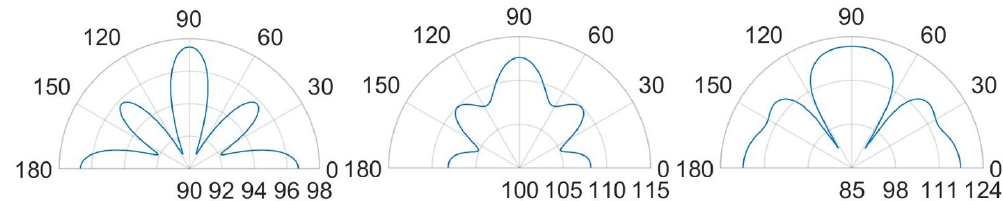
Figure 23. SPL polar plot (dB) at the performing fundamental frequency of 85.5 kHz (10 V bias), at 3.5 cm in the y(90 ◦ )–z(0 ◦ ) plane: (a) ( left ), (b) ( center ), (c) ( right ).